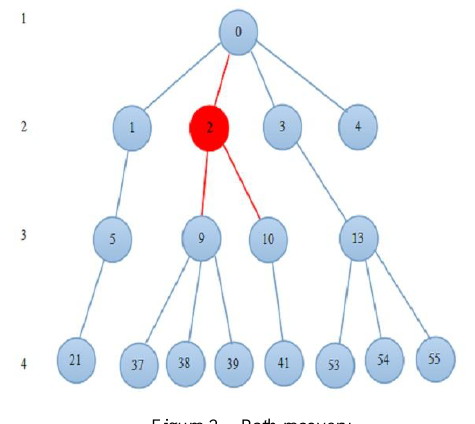
Figure 2. Path recovery.